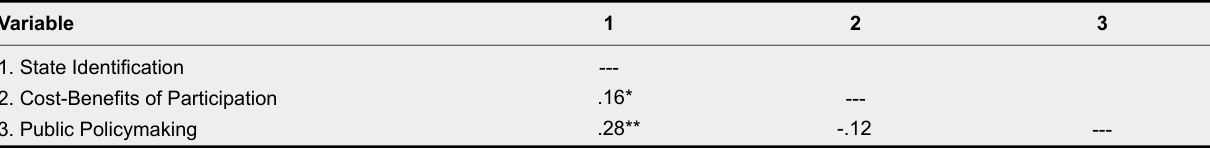
Study 1: Correlations Between Predictor and Dependent Variables